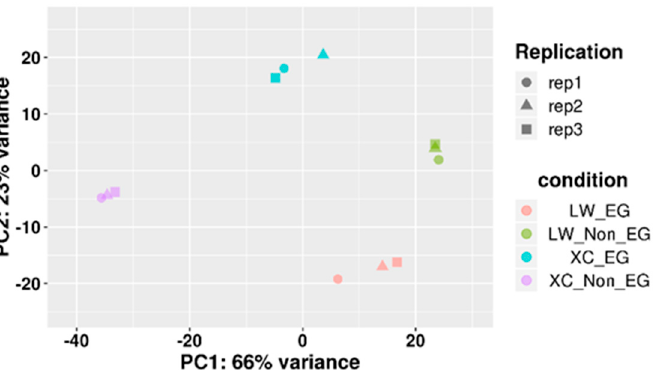
Figure 3. Principal component (PC) analysis of four treatments. Abbreviation: LW_EG, the LW variety sprayed with EE-GRSP; LW_Non_EG, the LW variety not sprayed with EE-GRSP; XC_EG, the XC variety sprayed with EE-GRSP; XC_Non_EG, the XC variety not sprayed with EE-GRSP.